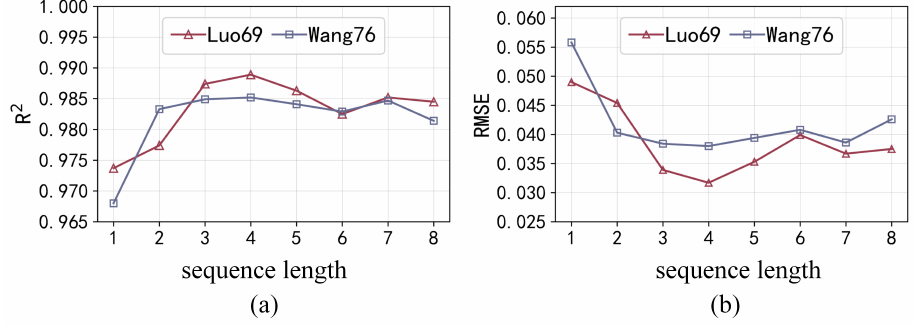
Figure 17. The sequence length selection experimental results on ( a ) R 2 and ( b ) RMSE for ISS